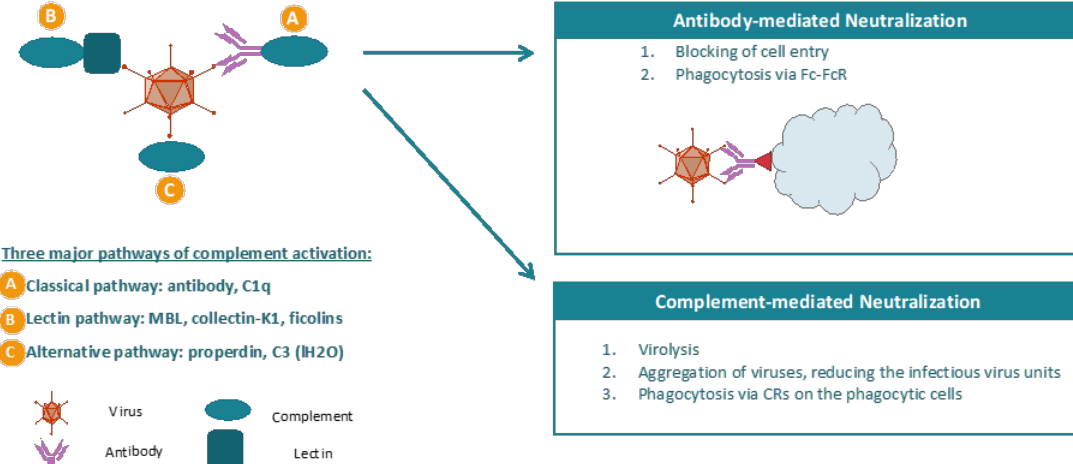
Figure 2. The mechanisms of antibody- and complement-mediated neutralization of virus. Antibody can block cell entry of virus. In addition, antibody can lead to phagocytosis of the virus via Fc–FcR interaction. The complement system is activated primarily by three pathways, including classical pathway, lectin pathway, and alternative pathway. In the classical pathway, viral antigen is recognized by neutralization antibody. The viral antigen–antibody complex induces activation of complement system. Neutralization of viruses by complement occurs owing to different mechanisms. First, virus can form a membrane attach complex (MAC) on the viral envelopes and produce holes of ~100 A diameter in the virus membrane. In addition, opsonization of viral surface with complement can lead to aggregation of viruses as well as phagocytosis of these viruses via a complement receptor (CR) present on the phagocytic cells.